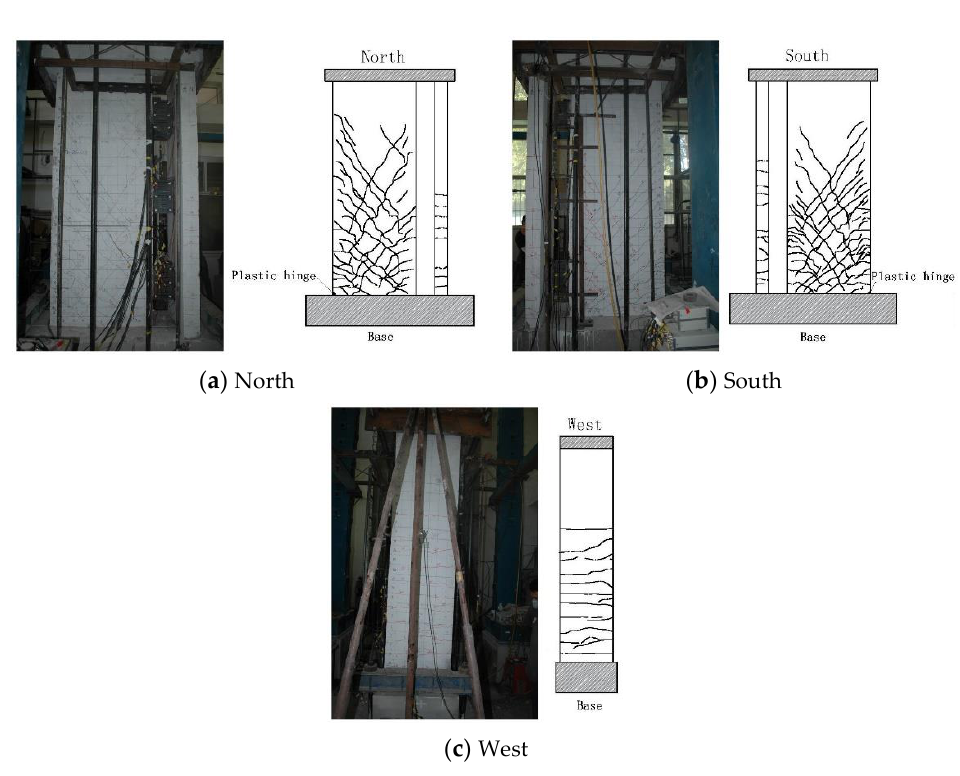
Figure 8. Failure model of specimen T-0.1. The failure mode of the specimens is seen in the plastic hinge at the lower part of the wall limb, the damper in the vertical joint reaches the yield, and no shear failure occurs at the joint between the wall limb and the foundation (horizontal joint) of each specimen. The failure mode was “strong horizontal joint, weak vertical